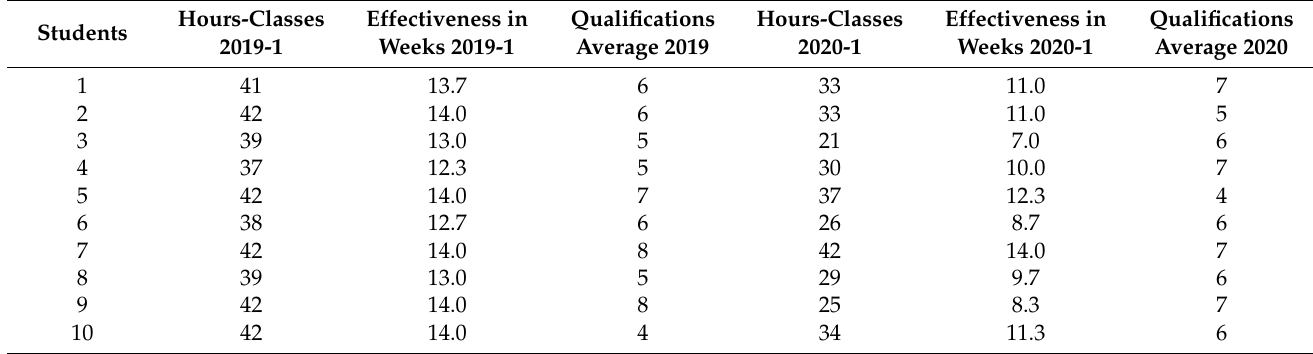
Table 5. Comparison of the effectiveness of class hours in the period